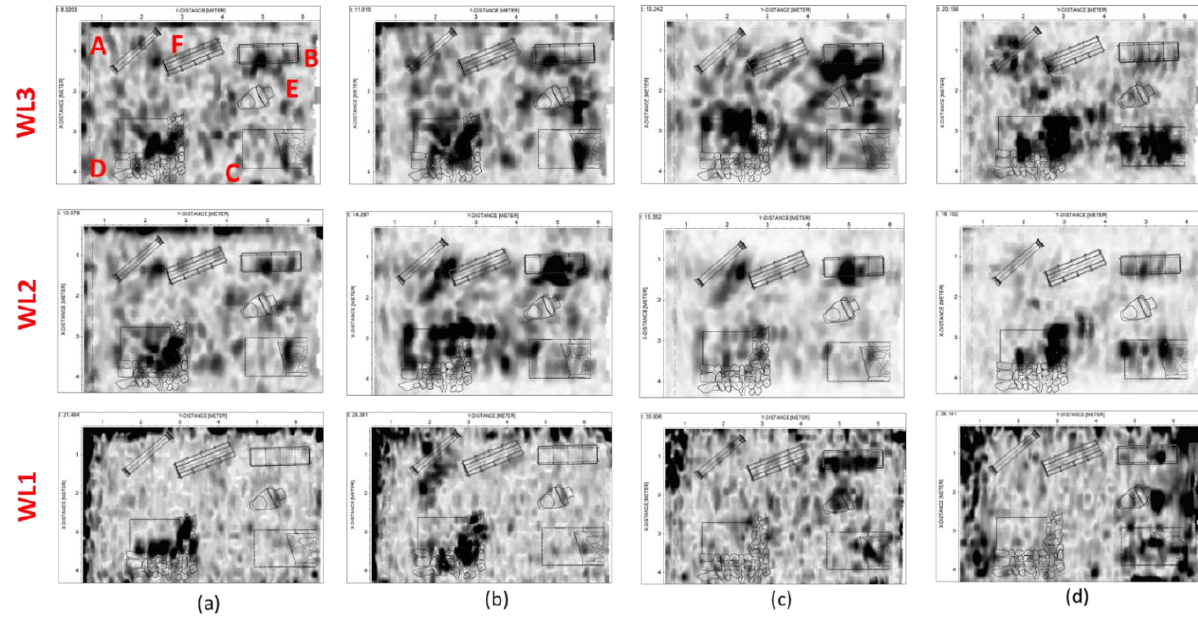
Figure 19. Comparison of GPR slices at the depths of 0.25 m ( a ), 0.45 m ( b ), 0.70 m ( c ) and 1.00 m ( d ) for the different scenarios in WP1.